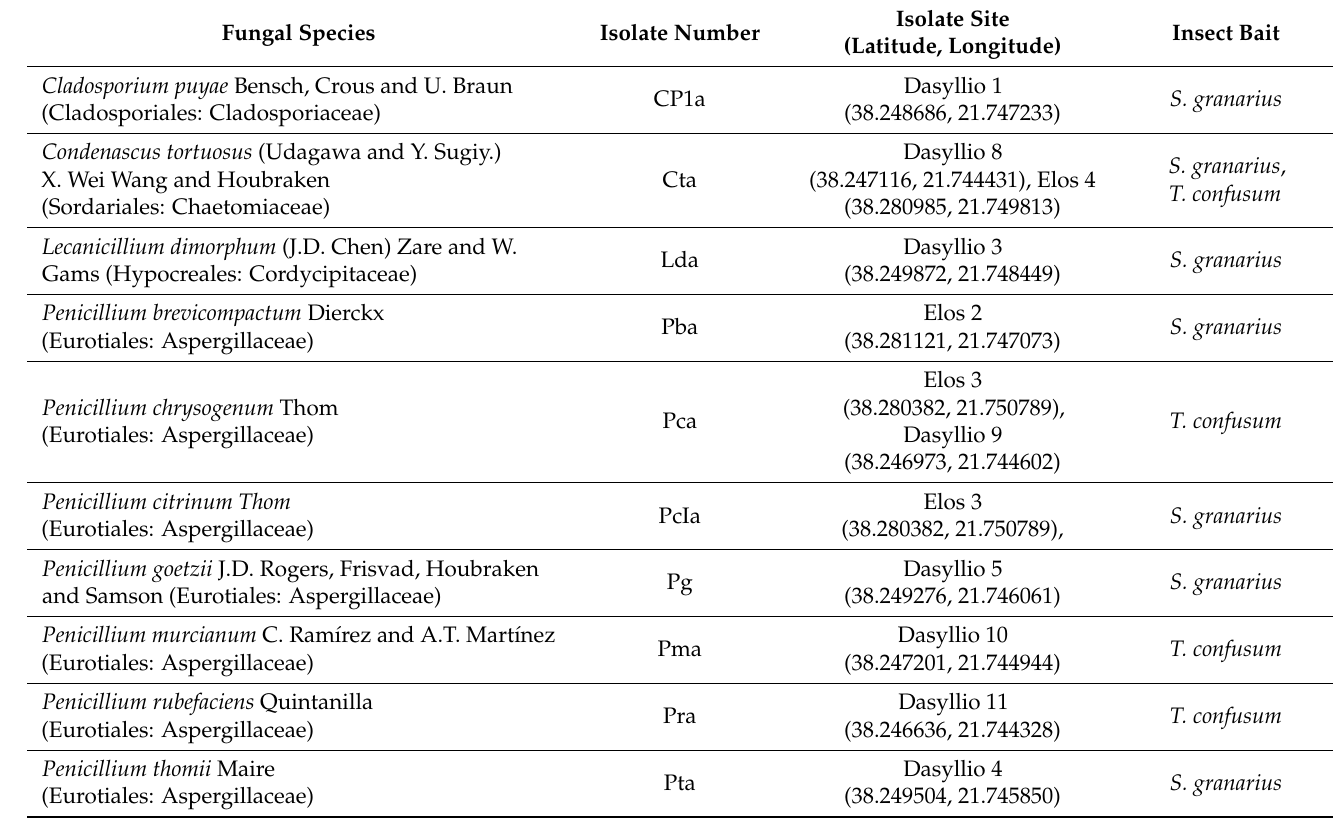
Table 1. Isolates of several EPF species that were tested in the present study. All collected fungal isolates were lab cultured and stored at 25 ◦ C in SDA plates.